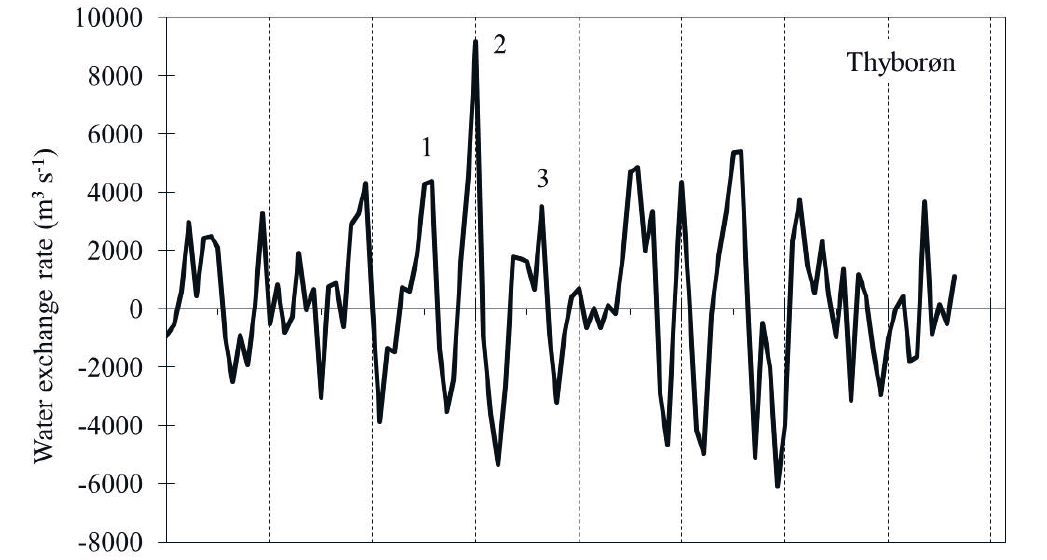
Figure 2. Water exchange in Limfjorden is mainly caused by strong westerly winds inducing intrusions of North Sea water through Thyborøn Kanal (Figure 1) and subsequent backflow of water during periods with more calm weather. The figure shows the daily water exchange rates through Thyborøn Kanal during the period 1 August to 16 November 2011. Incidents of three intrusions of water from the North Sea between the end of August to the middle of September 2011 are indicated (1–3). Easterly currents are indicated with positive values on the y-axis. From Riisgård et al.